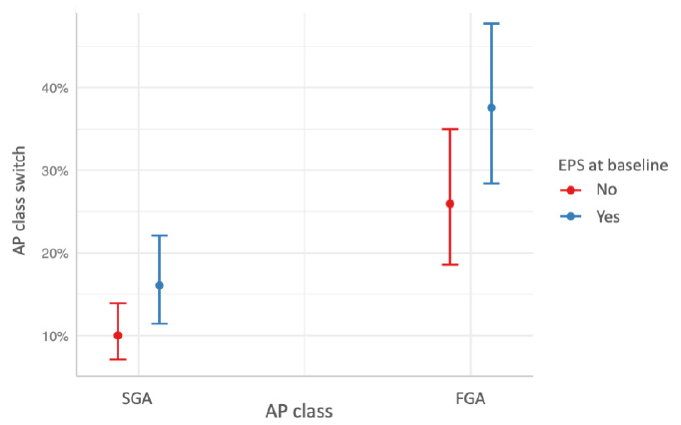
Figure 2. Predicted probabilities of switching antipsychotic (AP) class associated with AP class taken at baseline and the occurrence of extrapyramidal symptoms (EPS) at baseline. FGA = first-generation antipsychotics; SGA = second-generation antipsychotics.